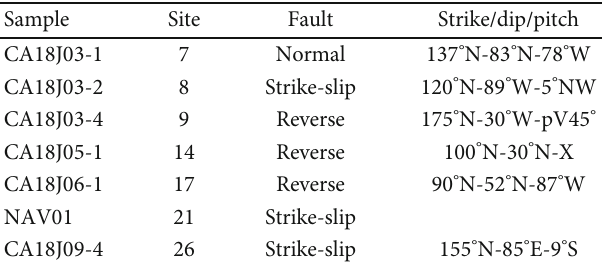
Figure 8: Tera-Wasserburg diagram ( 207 Pb/ 206 Pb vs. 238 U/ 206 Pb) of the seven fault-related calcite samples dated. The uncertainties correspond to the 2 σ error and “ n ” to the number of ablation spots performed for each sample. The numbers in parentheses correspond to the number of data removed for each T-W diagram. The uncertainties in brackets correspond to the propagated uncertainties (see Supplementary Materials for details). MSWD: mean square of weighted deviates. See Figures 5 and 6 and Table 2 for more details about the dated samples. Table 2: Detailed information for dated calcite samples. See Supplementary Materials for sample